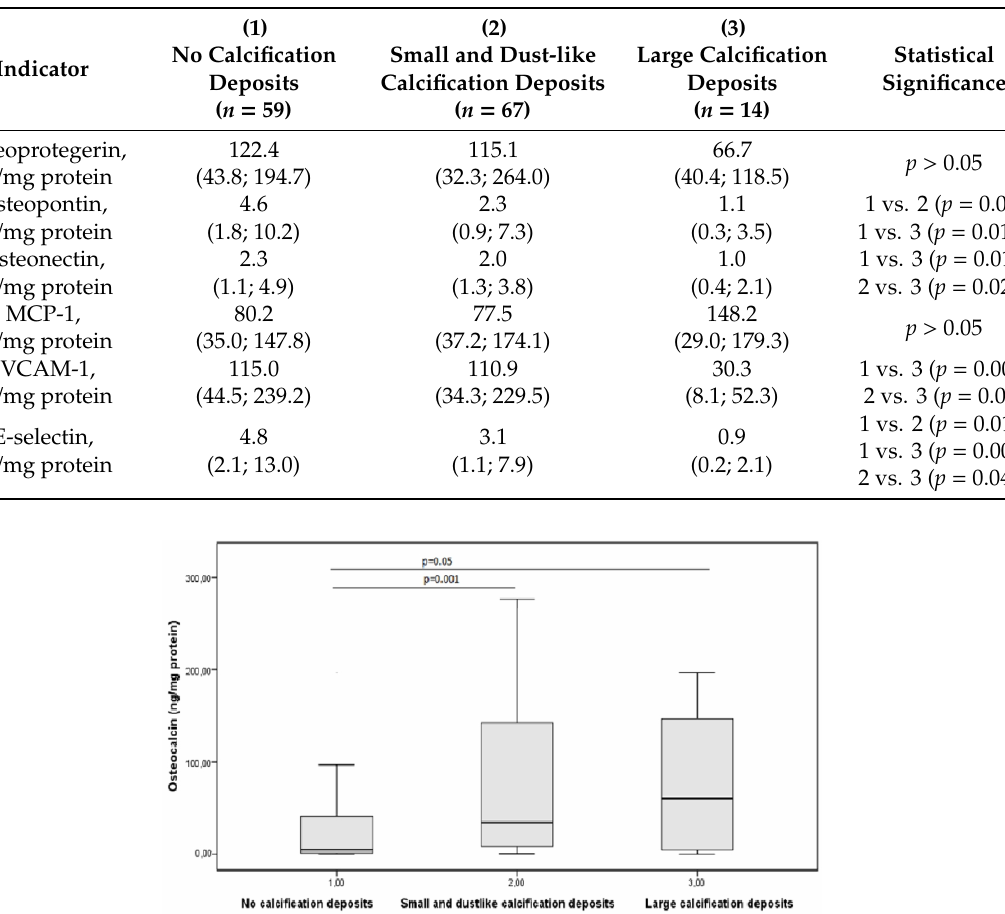
Table 3. Markers of calcification and of endothelial dysfunction in plaques showing di ff erent degrees of calcification (Me (25%; 75%)).